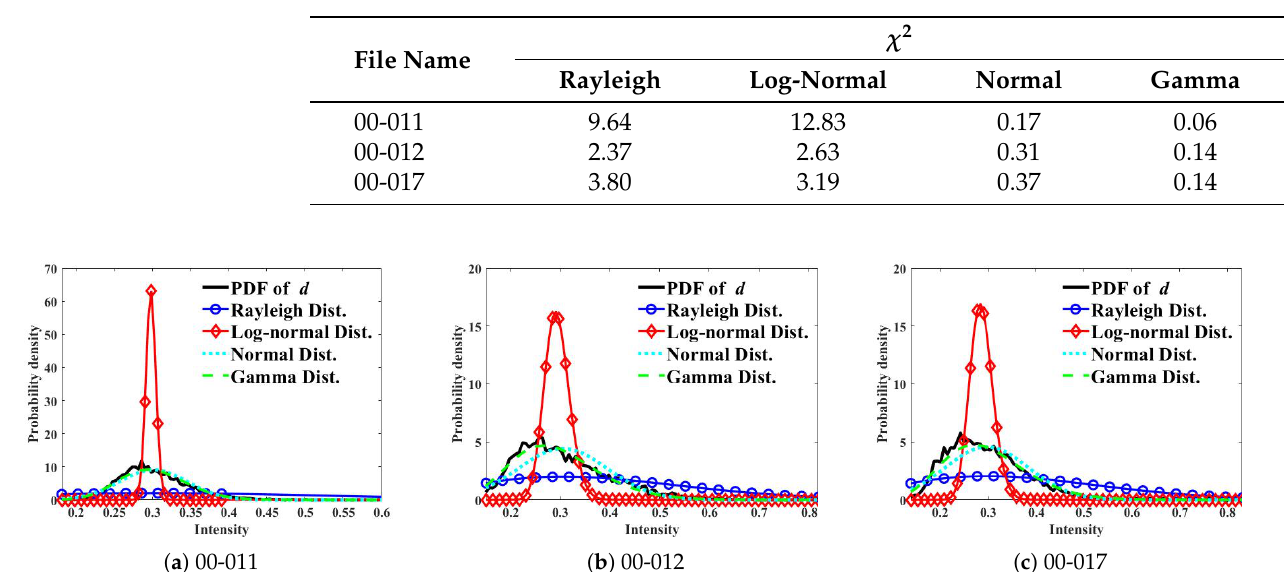
Figure 4. Comparison of the probability density function (PDF) of d with four distributions.